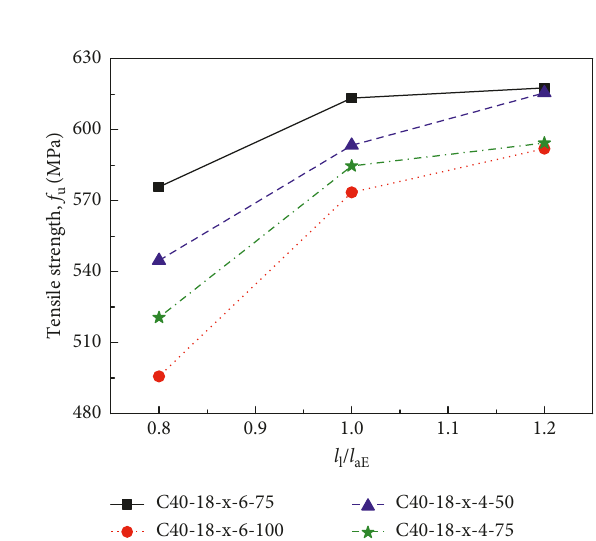
Figure 5: Tensile strength-lap length